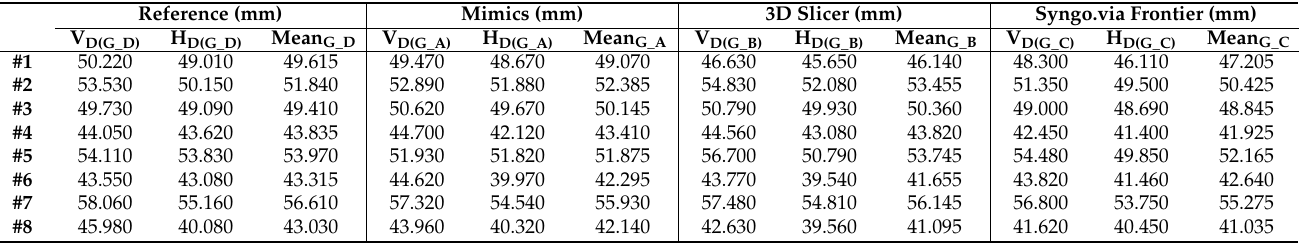
Table 3. Femur heads’ measurements (H D : horizontal diameter and V D : vertical diameter)